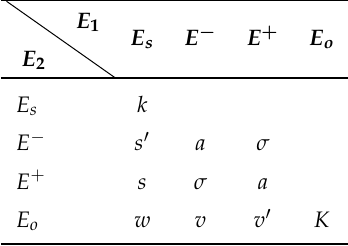
Table 1. Symbols of scattering and extinction coefficients for the possible combinations of incident ( E 1 ) and scattered or attenuated ( E 2 ) fluxes of single leaves. E 1 E 2